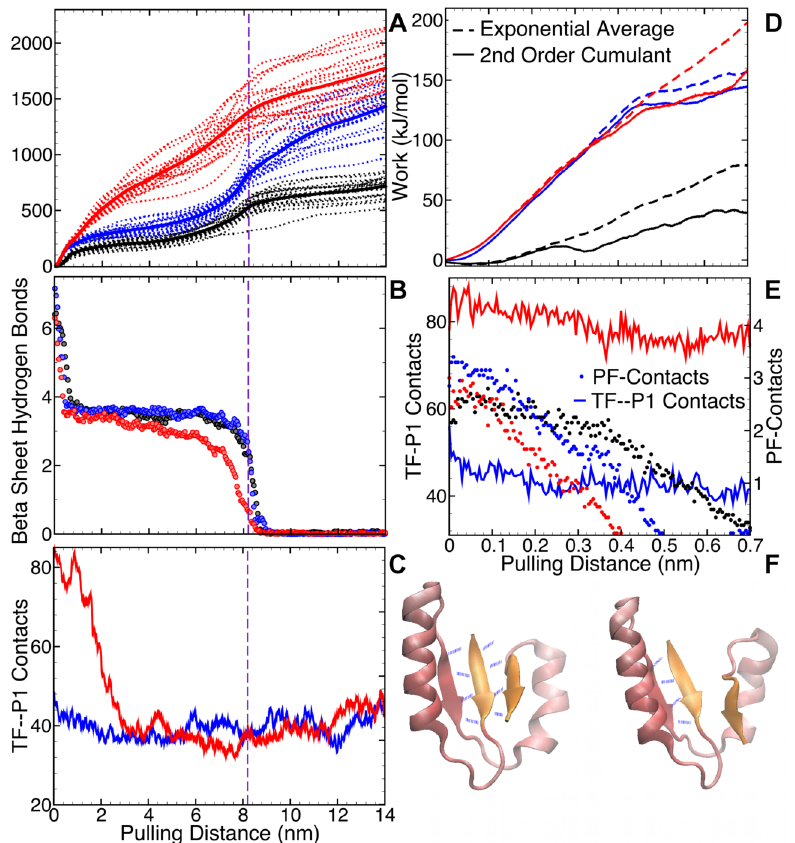
Fig 4. Steered MD simulations of pulling the folded P1 apart to unfold it in isolation (black lines), and in complexes with TF: HC1 (blue lines) and HC2 (red lines). A. Work-extension graphs of each trajectory (dashed lines) and average work (bold solid lines); B. Average number of P1 β – sheet hydrogen bonds in the three systems; C. Average number of TF-P1 contacts. The vertical dashed lines at pulling distance of 8.2 nm marks the end of the energy barrier. D. Plots of second order cumulant expansion (solid lines) and Boltzmann-weighted average work plot (dashed lines) for each system in the first 1.4 ns or over 0.7 nm of pulling. E. The PF-contacts (circles) are broken while TF-P1 contacts (solid lines) remain almost unchanged in the first 1.4 ns (or 0.7 nm) of pulling. F. Cartoon representation of the loss of 4 hydrogen bonds between the first and last β – strands (colored orange) of P1 upon